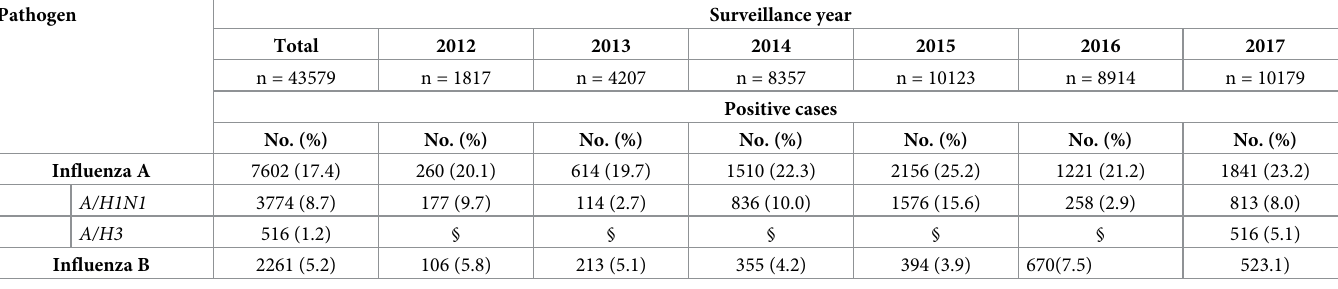
Table 2. Distribution of influenza viruses by year of detection.